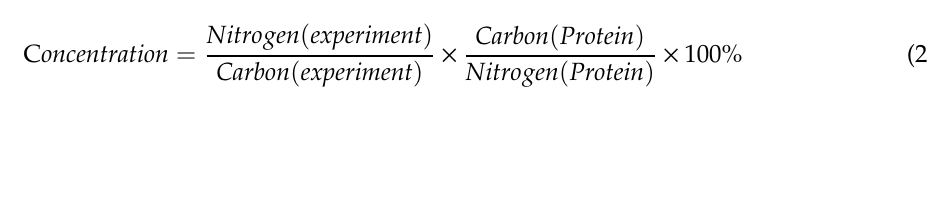
Figure 8a. The modeled FN and the experimentally measured PCL-COOH-FN spectra are shown in Figure 8b.